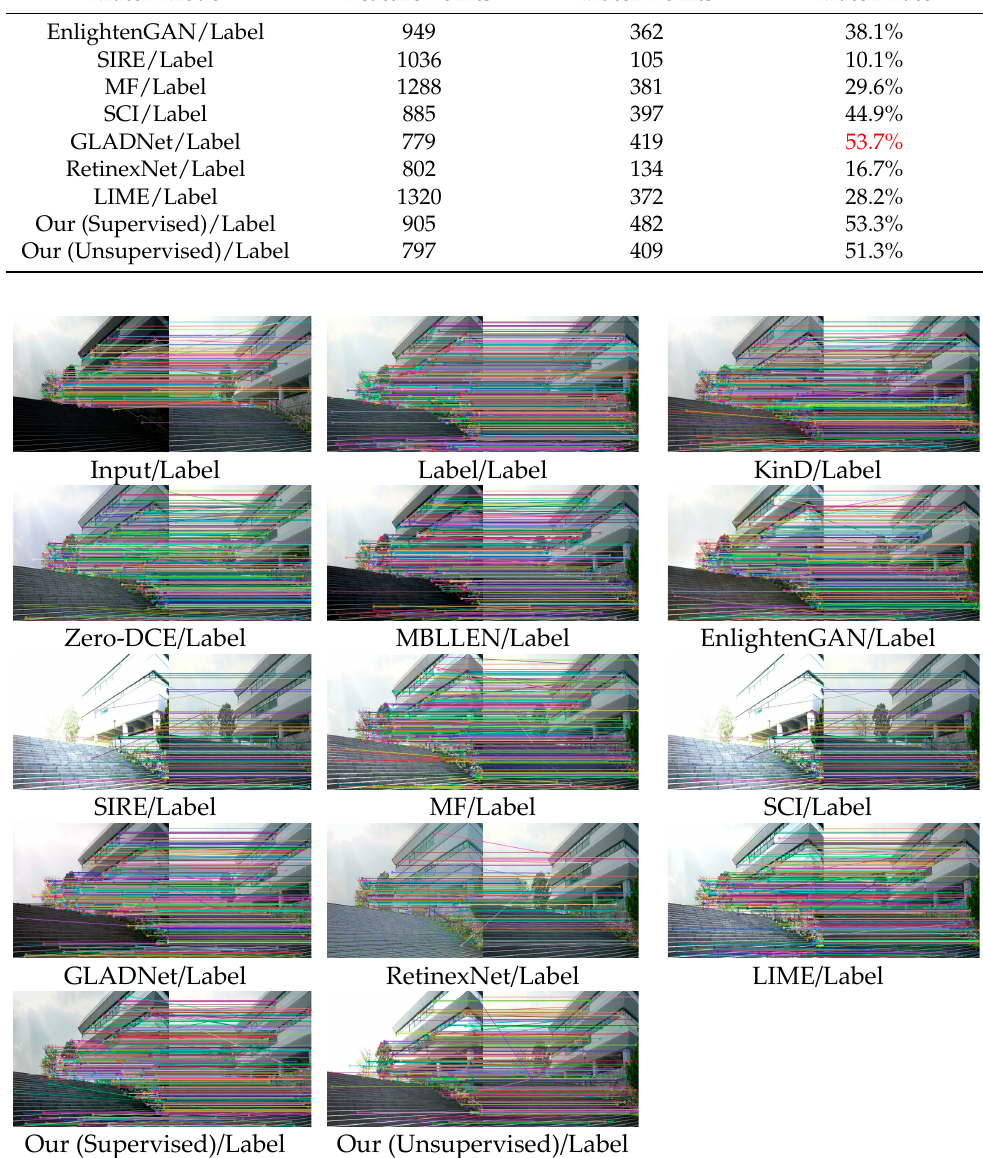
Figure 13. Visualization of image matching results enhanced by different algorithms. Table 7. Comparison of image matching results enhanced by different algorithms.